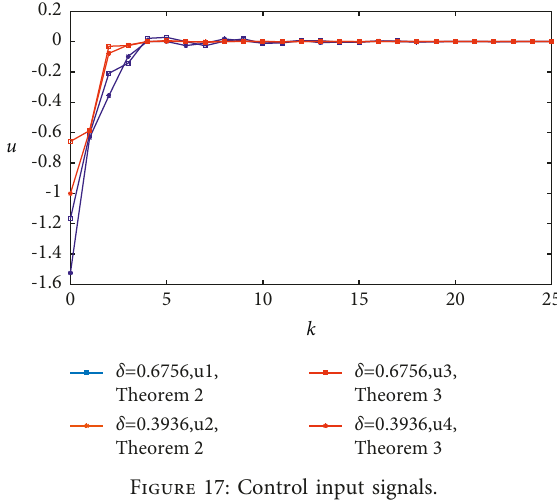
Figure 14: State trajectory with δ � 0 . 3936.